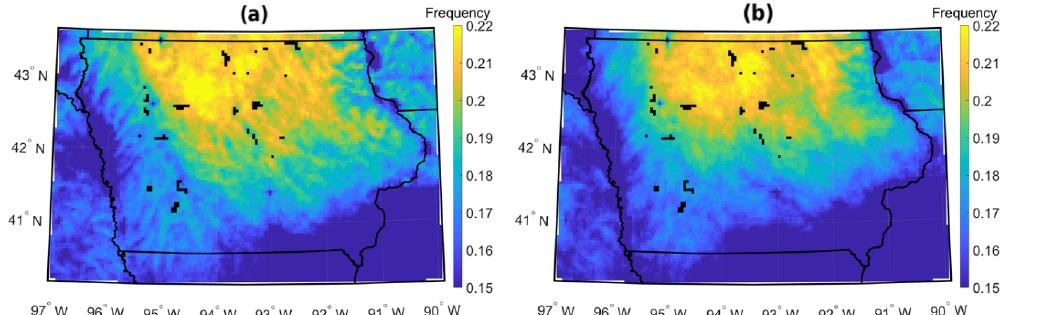
Figure 10. Spatial distributions of LLJ frequency computed using a detection algorithm with a (a) 20% variable threshold and a (b) 2ms − 1 fixed threshold.